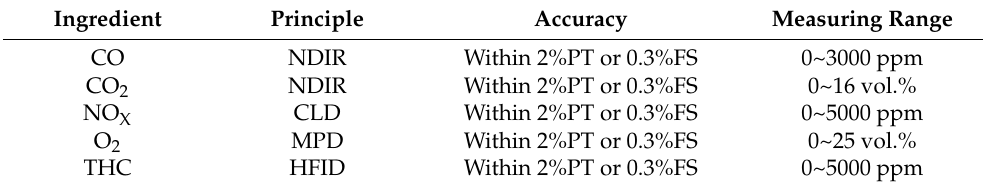
Table 4. Gaseous-substance-measuring equipment specific